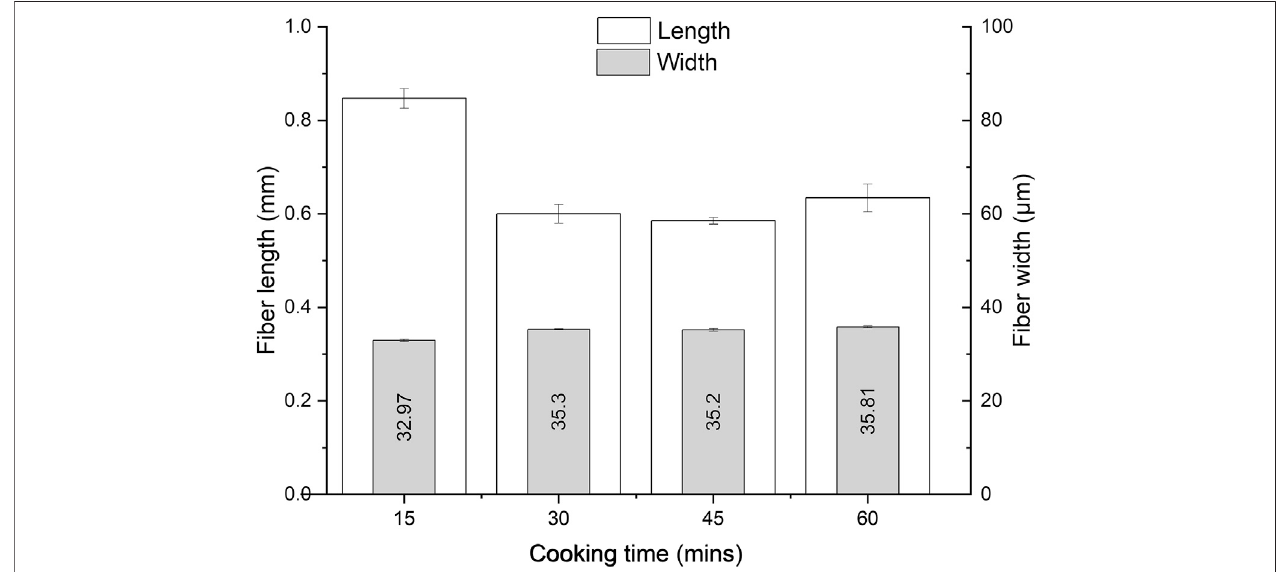
FIGURE 6 | The effect of the cooking time on the fi ber length and width in the DES-cooking of Asplund (the L/W of 27:1 at 130 ° C by using the RE setup).